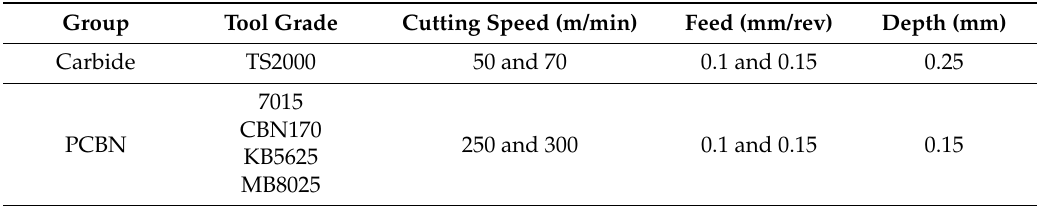
Figure 2. Undeformed chip cross section increment at the end of each pass. Table 3. Cutting parameters.